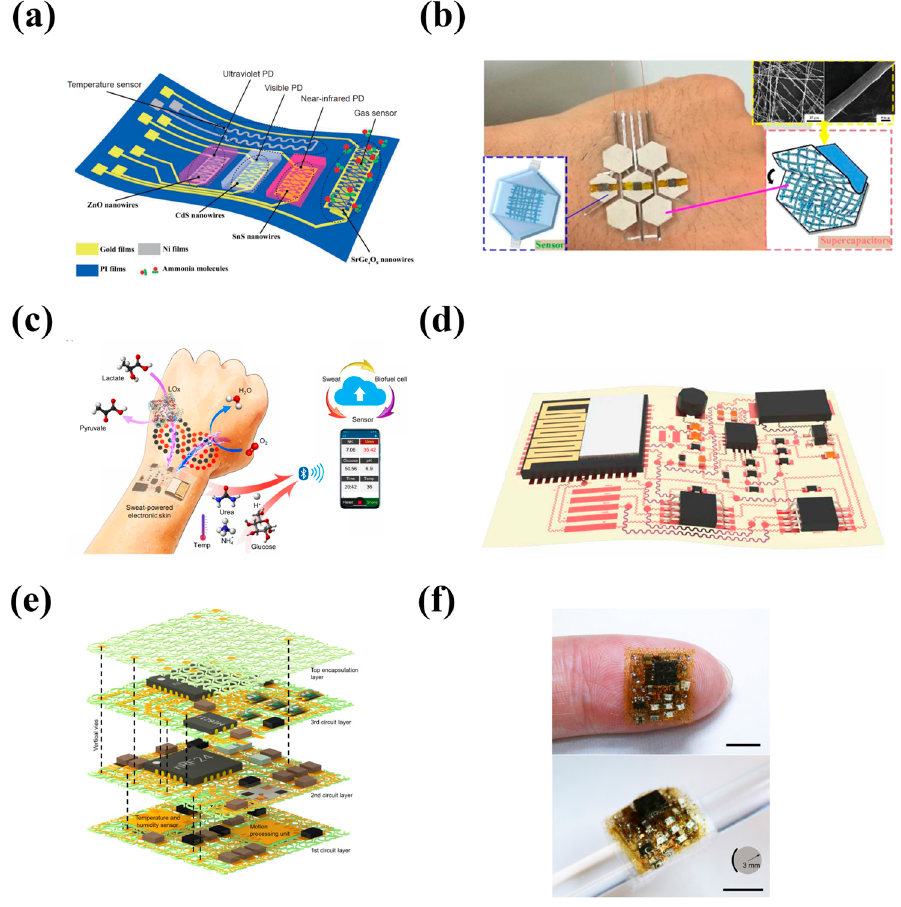
Figure 9. Schematic of ( a ) the system with multiple sensors. Reprinted with permission from Ref. [150]. Copyright 2020, Science China Materials. ( b ) Sensors (pressure sensors, photodetectors, and gas sensors) and on-chip micro supercapacitors integrated in one pixel. Reprinted with permission from Ref. [151]. Copyright 2017, Nano Energy. ( c , d ) The highly integrated soft E-skin with wireless multi-sensing. Reprinted with permission from Ref. [34]. Copyright 2020, Science Robotics. ( e ) Exploded view and ( f ) photographs of a highly integrated system based on stacked multilayer network materials. Reprinted with permission from Ref. [153]. Copyright 2022, Science Advances.